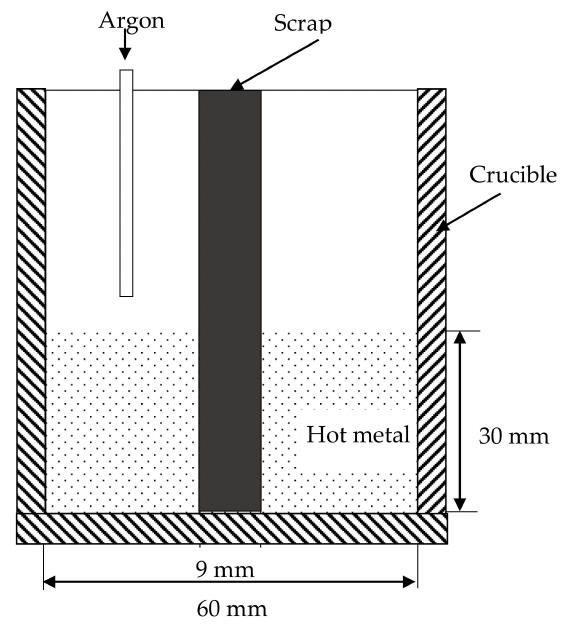
Figure 1. Schematic of the experiments. Table 1. The composition of the hot metal and the scrap bar used in the experimental parameters.